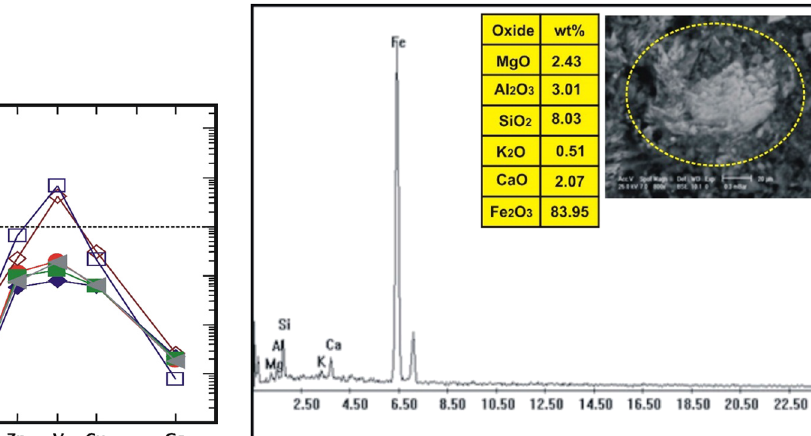
Figure 13: ESEM - EDX analysis of magnetite partially oxidized to hematite in basalt dike at Wadi Geba.